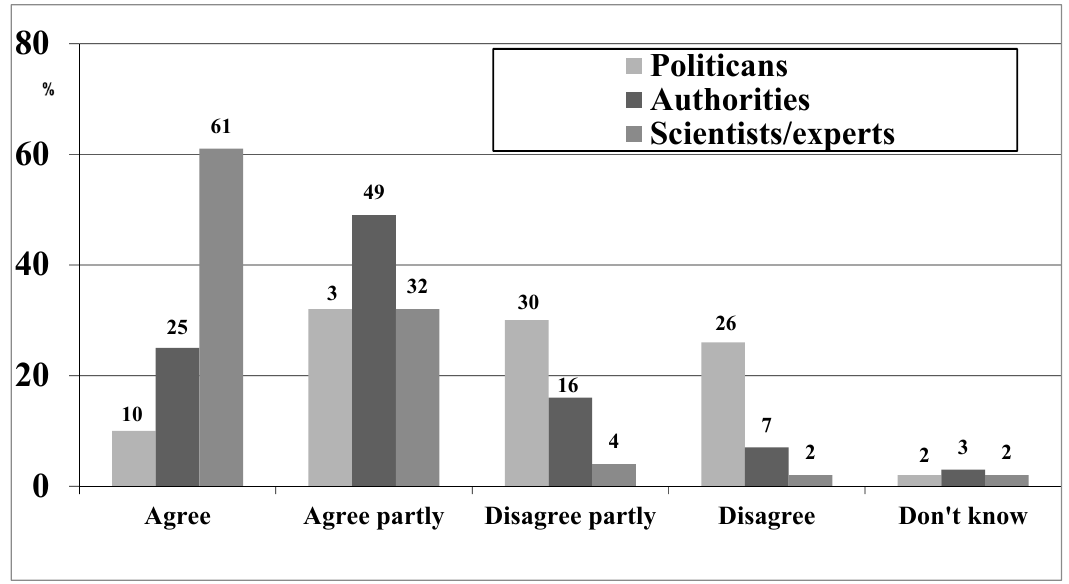
Figure 7. Question just to the citizens: I trust the decisions/investigations by the politicians’/authorities’/scientists and experts’ on where and how to build a final repository.